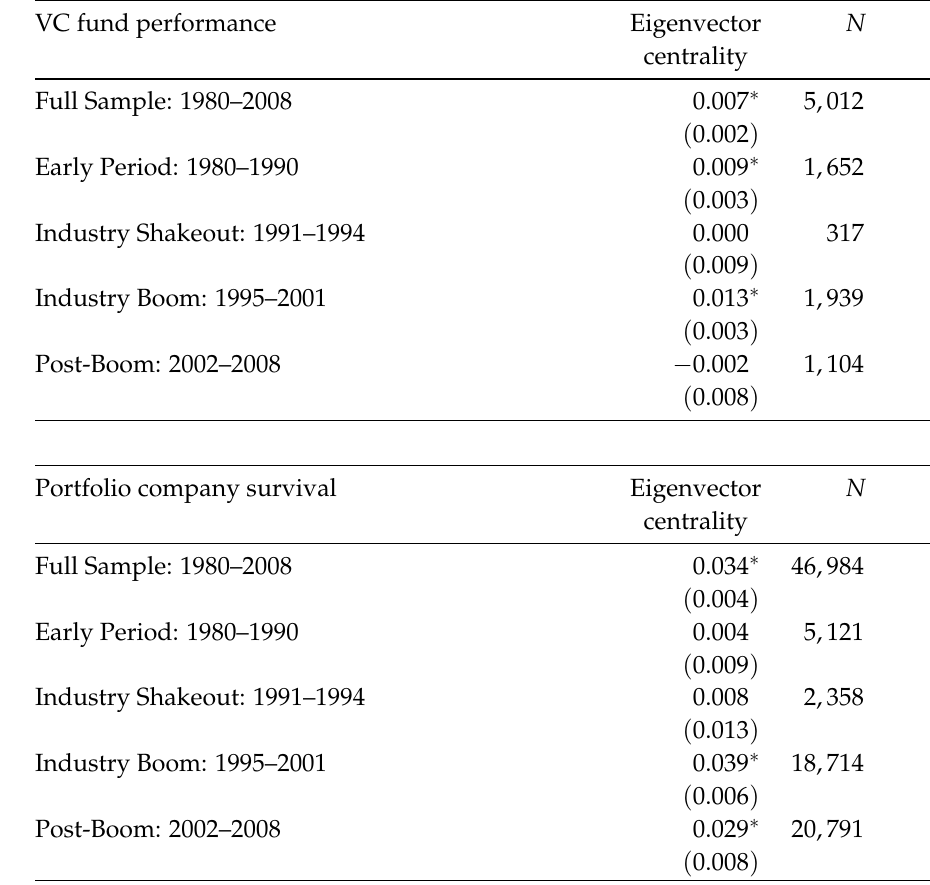
Table 5: Coefficients for eigenvector centrality on fund performance and company survival by time